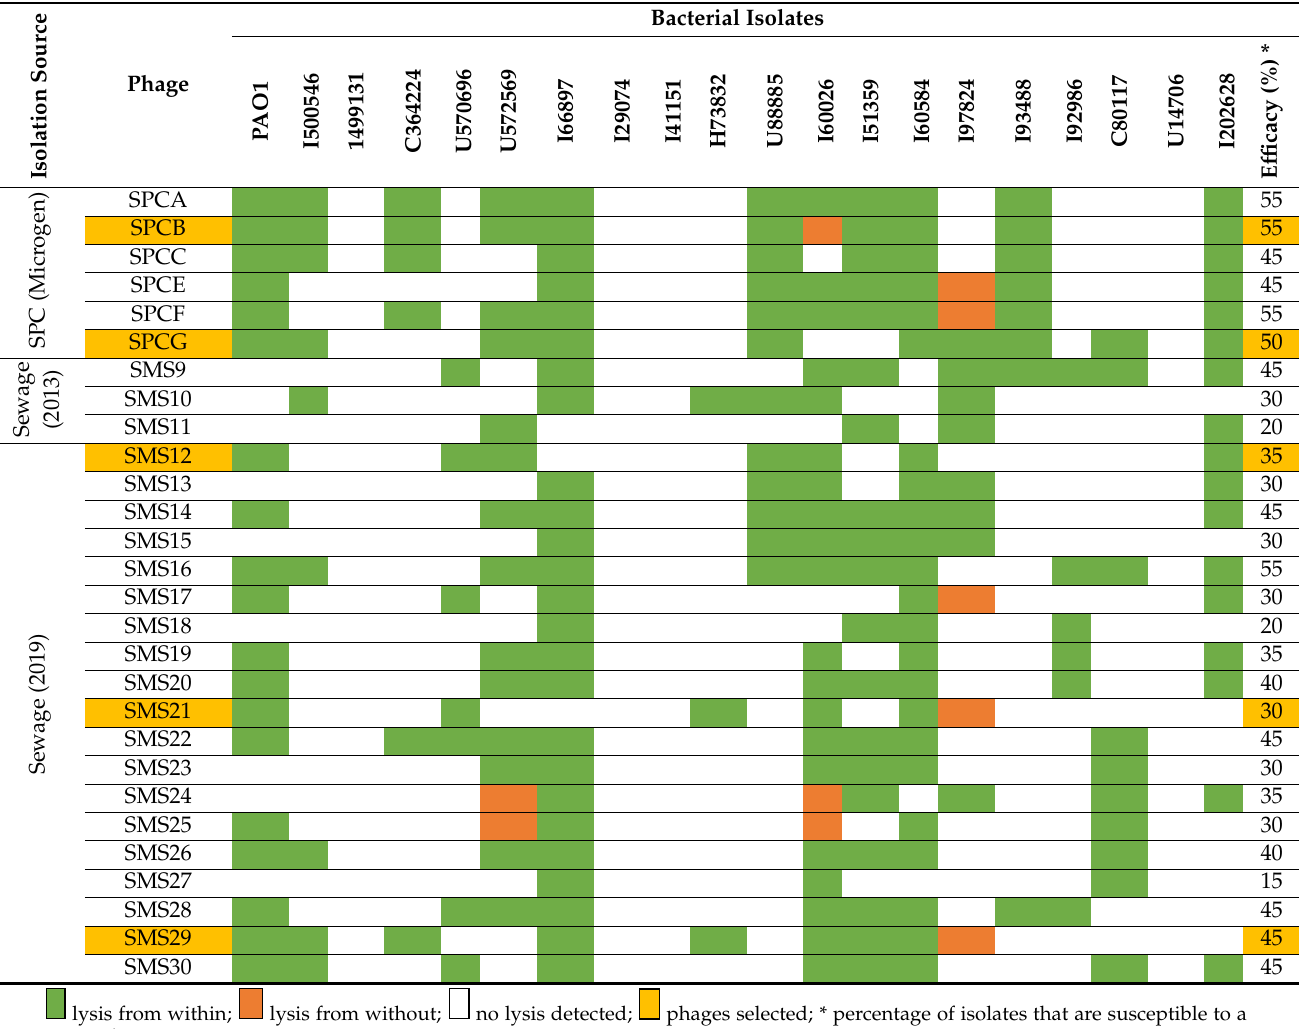
phages selected; * percentage of isolates that are sus-